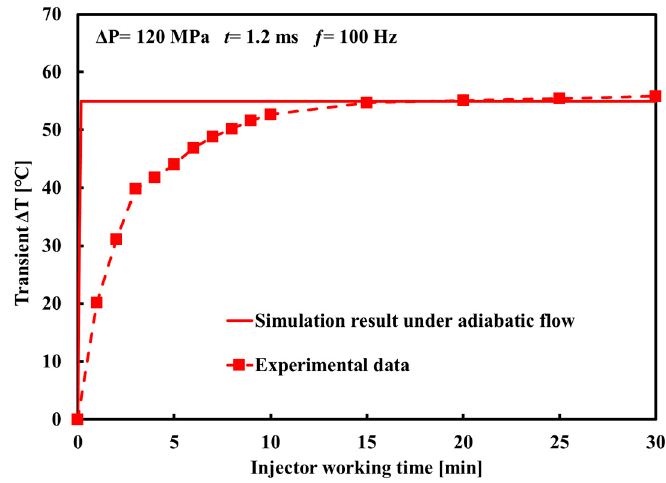
Figure 7. Comparison of the calculated Δ T under adiabatic flow with experimental data.